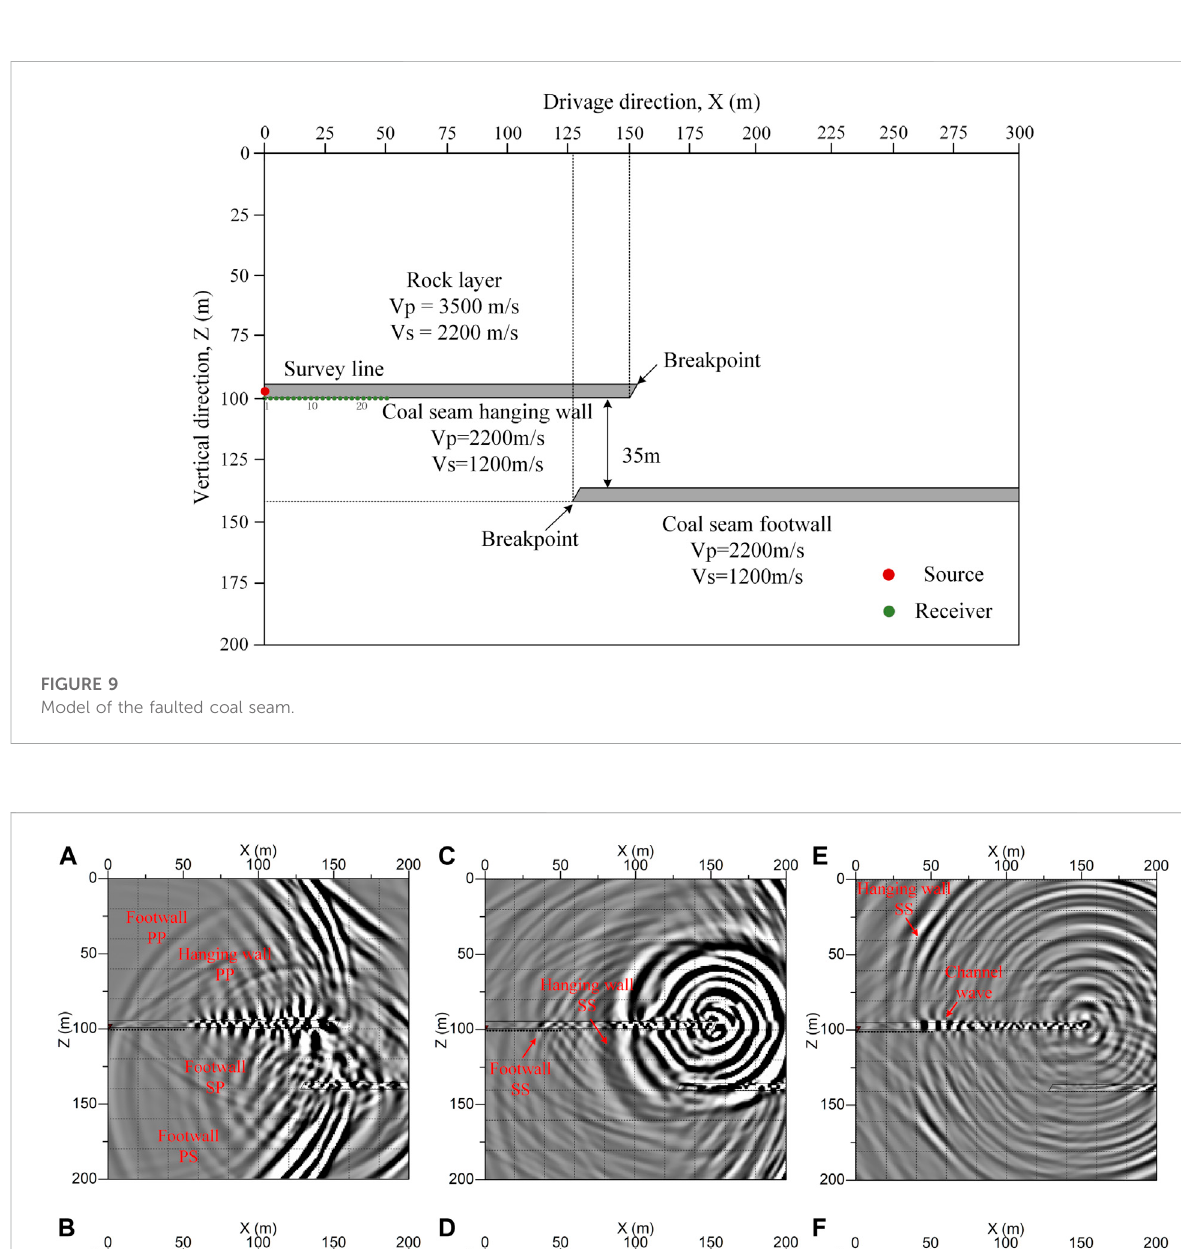
Frontiers in Earth